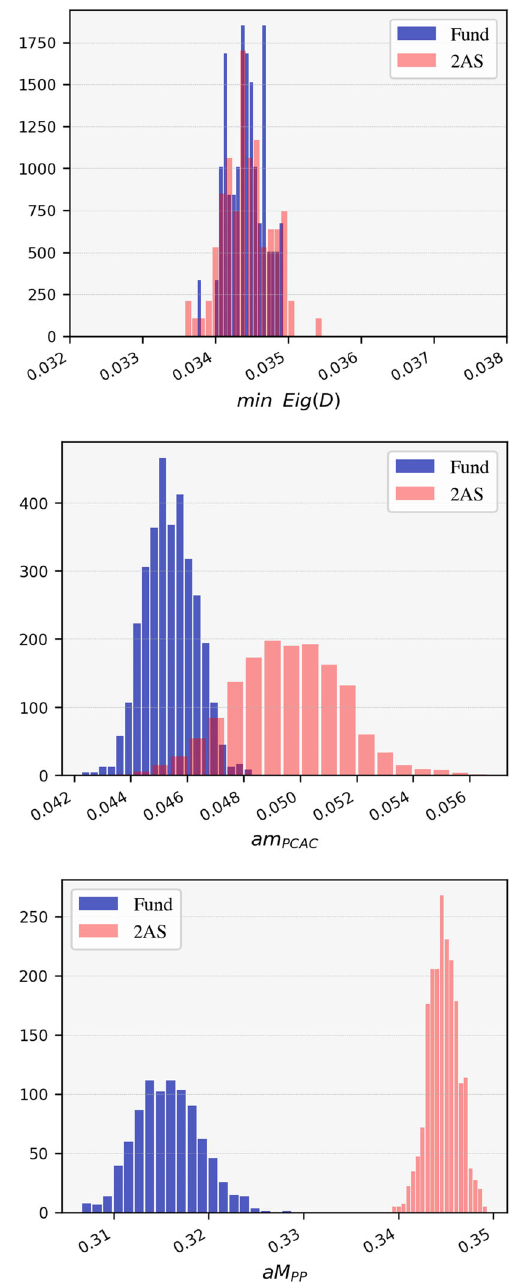
Fig. 4 Probability densities for the lowest eigenvalue of the fermionic operator (upper panel), the PCAC mass (central panel) and the pseu- doscalar mass (lower panel) for both representations. These values are especially interesting since they are based on the ensemble S0, where we find compatible values for the lowest eigenvalues and, within 1 σ, the PCAC masses. Nonetheless, a difference arises in the pseudoscalar masses. The distributions of the PCAC and the pseudoscalar masses are obtained from a resampled set of configurations